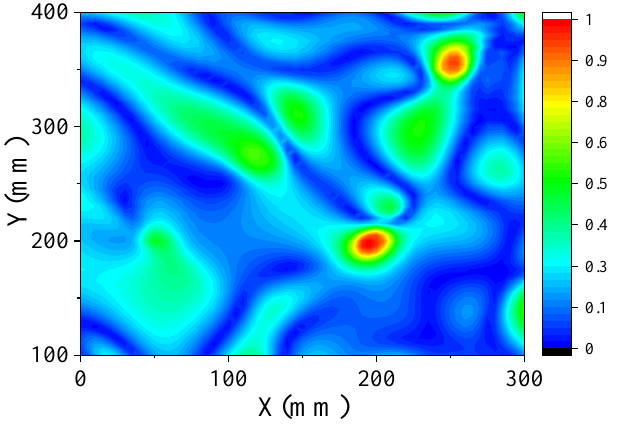
Figure 14. Imaging results of center frequency for multiple PIM sources.